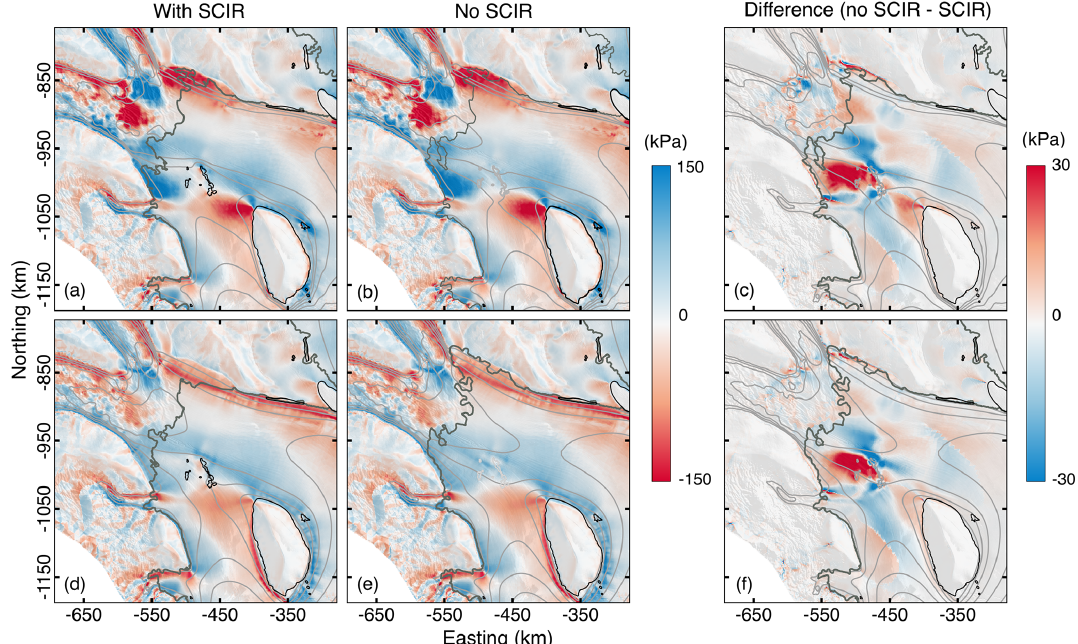
Figure 8. The lateral shear stress resisting RIS and tributary ice-stream flow with and without the SCIR. Negative and positive R lt magnitudes denote shearing along glacier-left or glacier-right margins, respectively. Difference maps show the absolute difference in R lt . In panels (a) – (c) , the simulation is initialised with B inv . In panels (d) – (f) , the simulation is initialised with B u . In panels (c) and (f) , a positive (negative) change indicates an increase (decrease) in R lt after removal of the